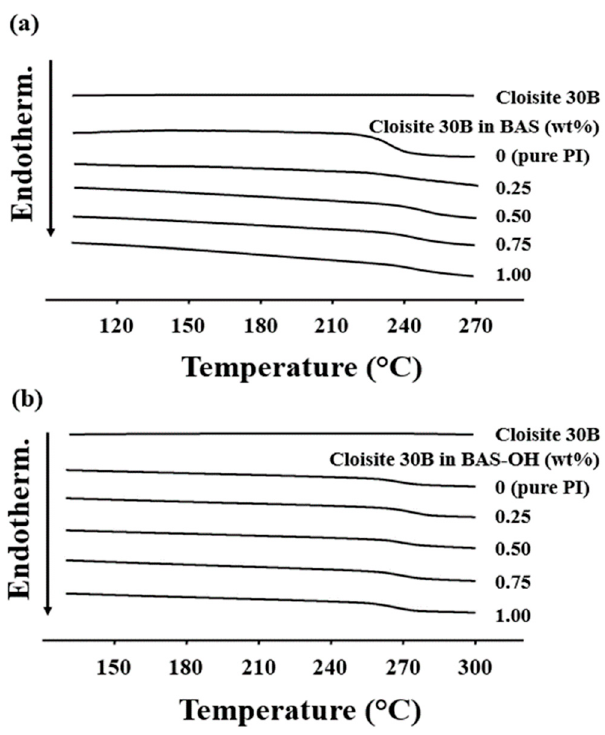
Figure 7. DSC thermograms of PI hybrid films with various organoclay. contents: ( a ) BAS and ( b ) BAS-OH.